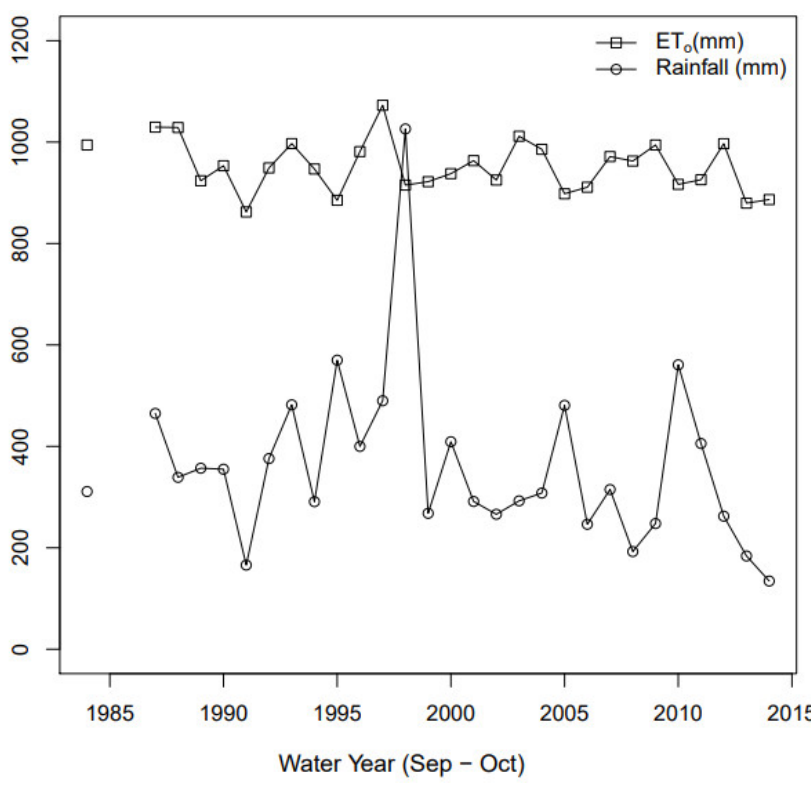
Figure 2. Annual rainfall and reference ET o from CIMIS station 19 in Castroville, CA.